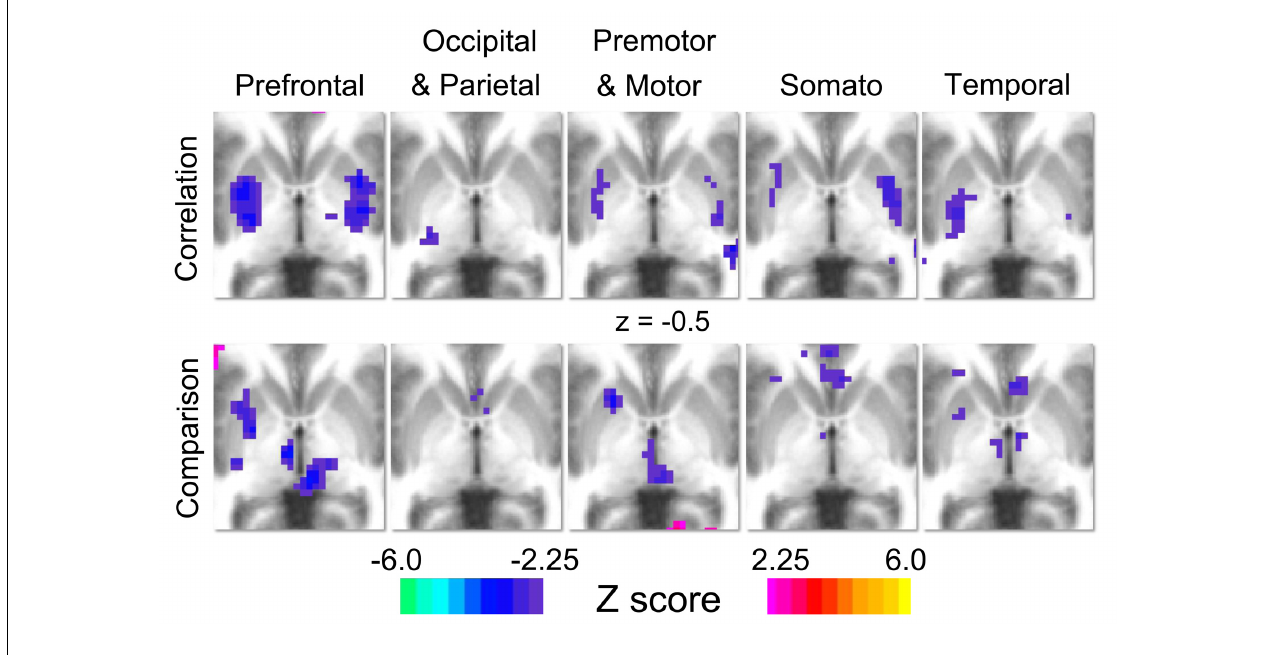
strength is negatively correlated with spatial span backward total scores. For the comparison analysis (row 2), warm colors (positive z -scores) indicate areas where connection strength is greater in typically developing control population, and cool colors (negative z -scores) indicate areas where connection strength is greater in the ADHD-C